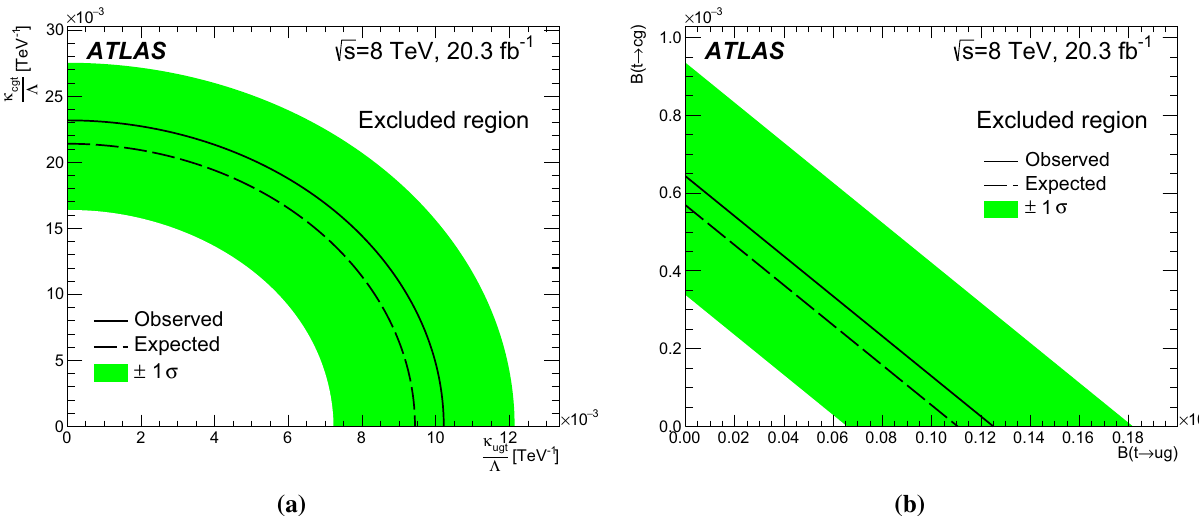
Fig. 10 a Upper limit on the coupling constants κ ugt and κ cgt and b on the branching fractions B ( t → ug ) and B ( t → cg ) . The shaded band shows the one standard deviation variation of the expected